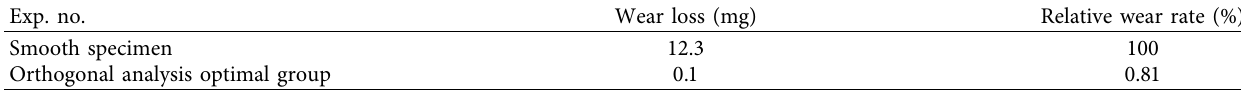
Table 5: Mass wear rate under mixed lubrication conditions.